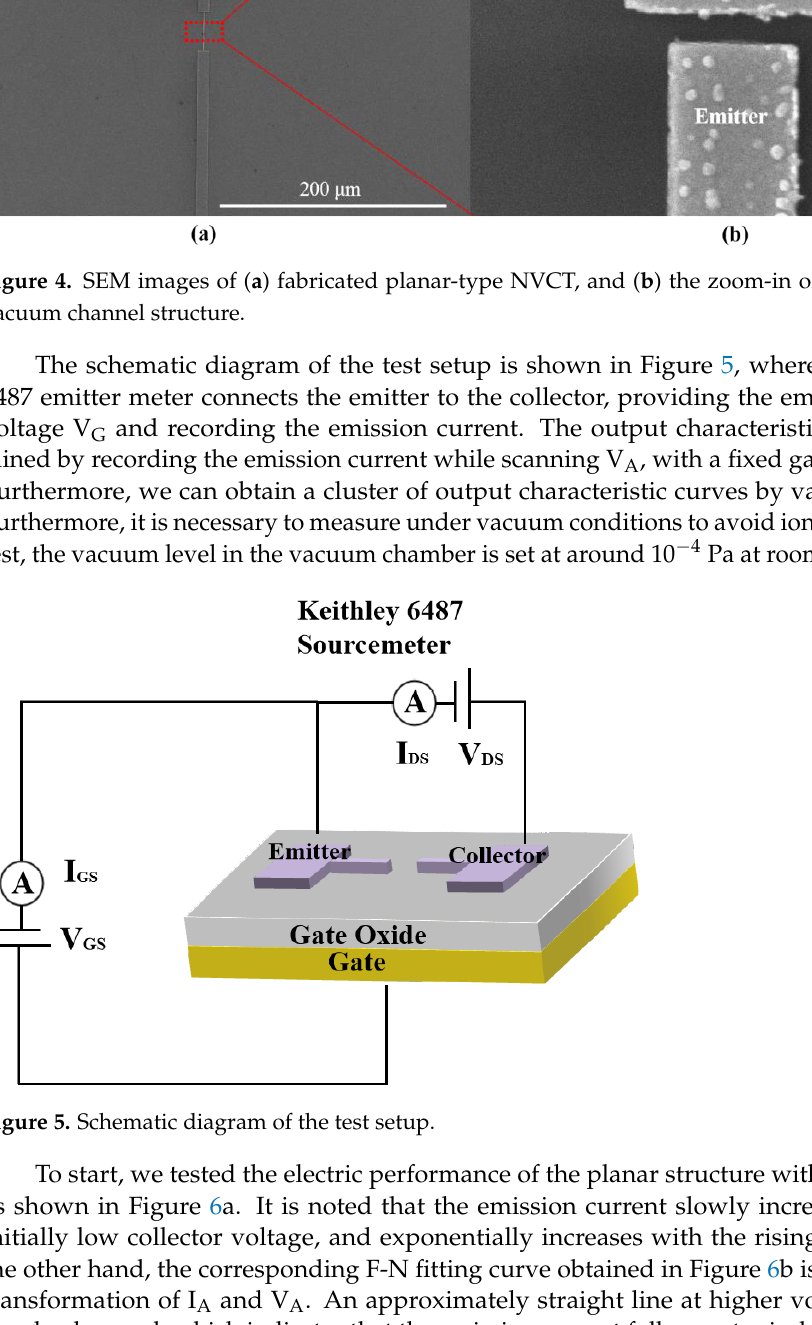
Figure 3. Emission current versus collector voltage for different emitter tip morphology.